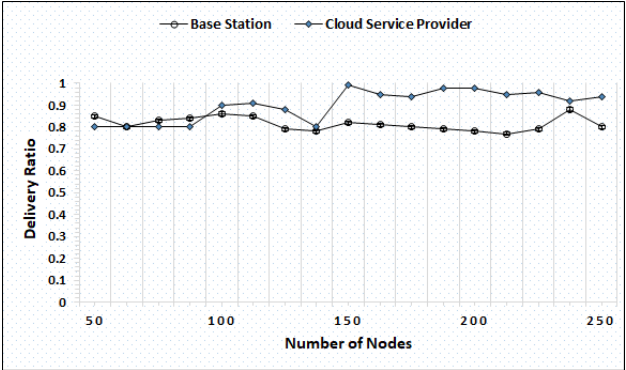
Figure 3. Delivery ratio evaluation by varying